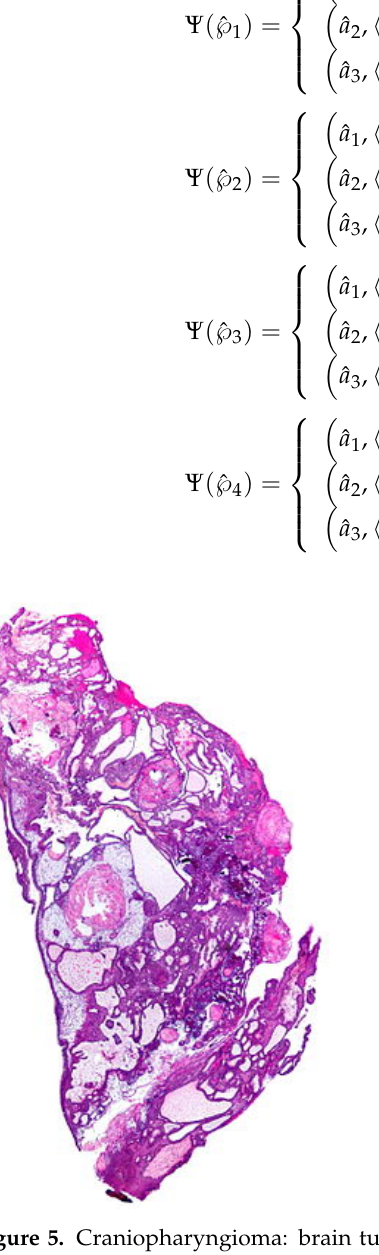
Figure 5. Craniopharyngioma: brain tumour of type 1 (source: https://en.wikipedia.org/wiki/ Craniopharyngioma) (accessed on 16 October